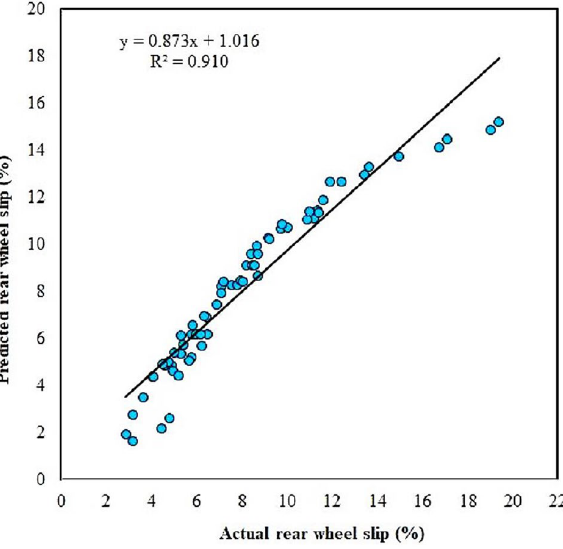
Figure 11. Variations of the observed and MLR-predicted tractor rear wheel slip during tillage operation using the testing data